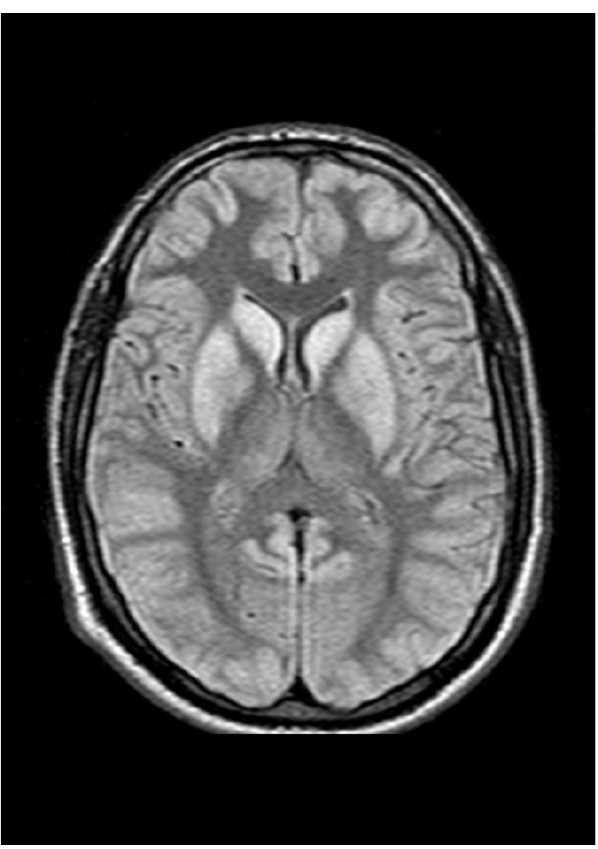
Figure . MRI of Brain Showing Multiple T2/FLAIR Hyper-Intense Foci in Bilateral Head of Caudate Nucleus, (Left > Right) Bilateral Dorsal Thalamus, Deep Whited Matter of Bilateral Perirolantoic Cortex. They Appear Hypo Intense, on T1W1 Shows Enhancement. Mild Atrophy of Right Caudate Nucleus is